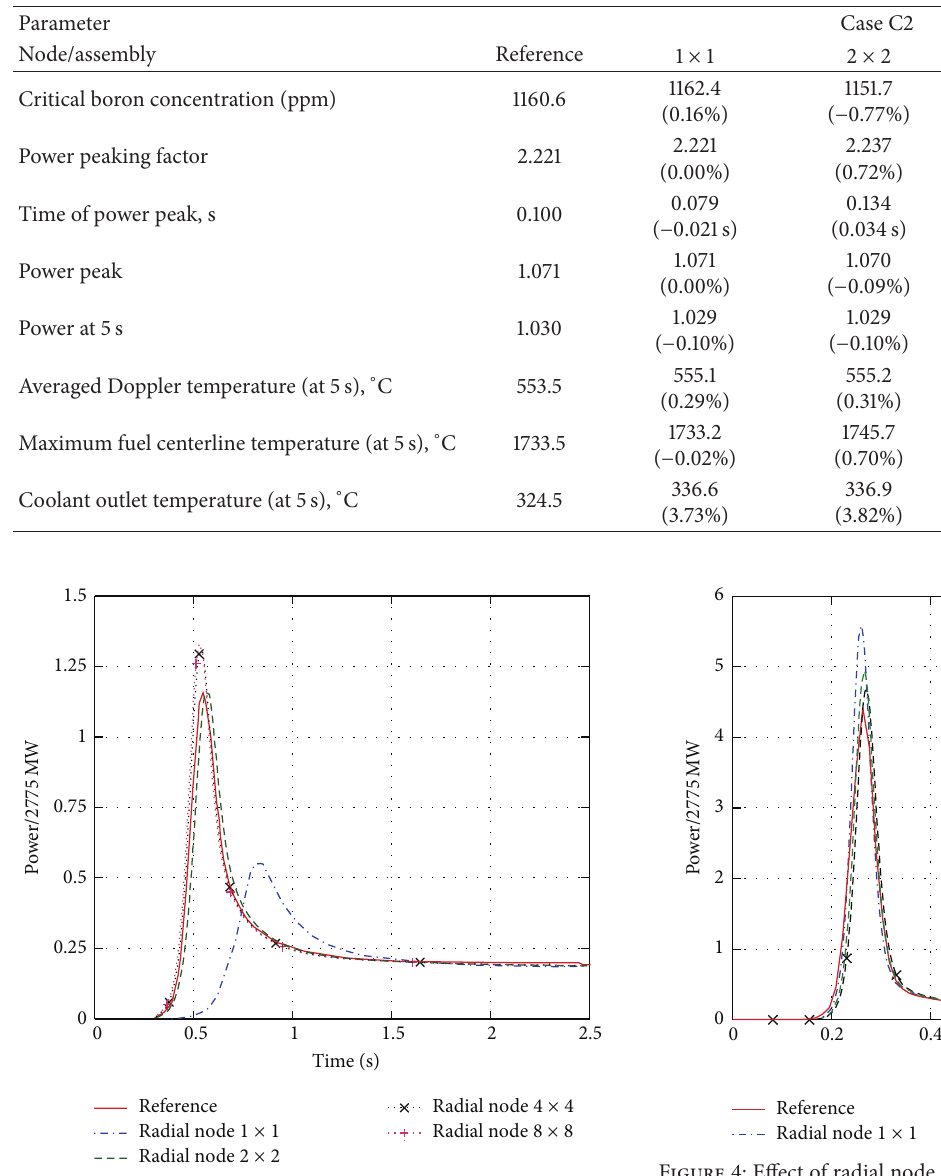
Table 3: Sensitivity analysis results in the radial node number per assembly for case C2.